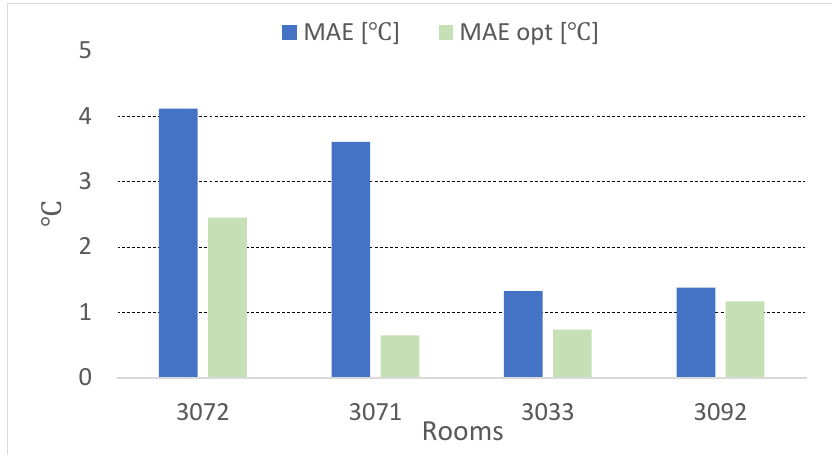
Figure 13. Mean absolute error for the air temperature: comparison calibrated model vs. optimized